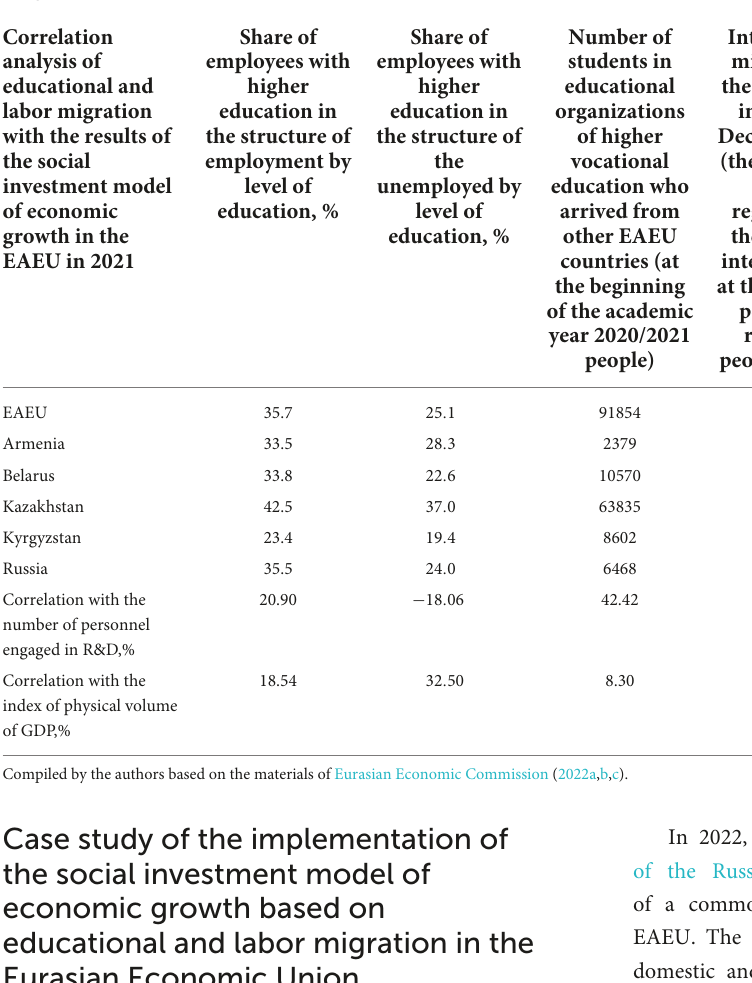
TABLE 1 Correlation analysis of educational and labor migration with the results of the social investment model of economic growth in the EAEU in